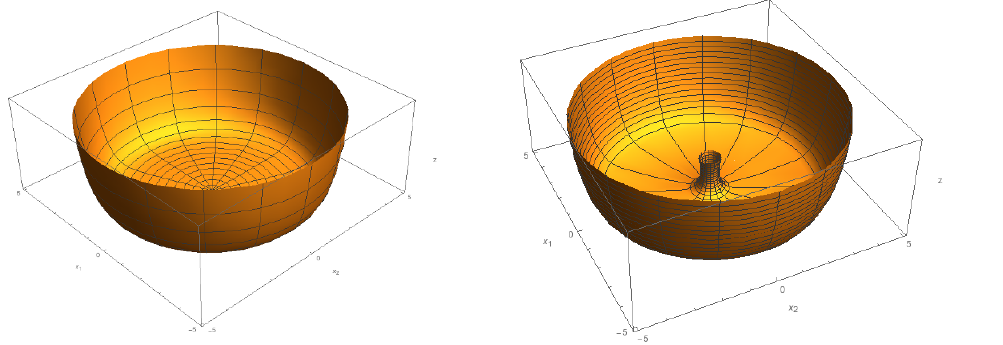
Figure 4 . Typical single loop solution ( I ), left and a double loop solution ( II ),